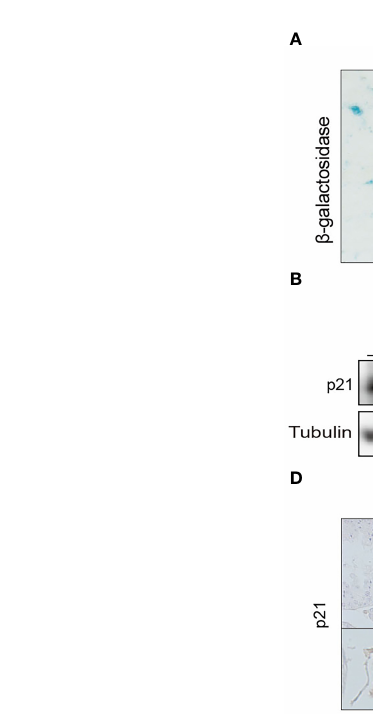
FIGURE 6 Assessment aging status of Leydig cell in p38LCKO mice and WT mice at 18-month of age. (A) SA- b -Gal staining in testes of two groups of mice was assessed by using staining kit. (B) The protein levels of p21 and p16 were detected by immunoblot. (C) Quantitative analysis for protein levels of p21 and p16. (D) IHC staining of p21 in testis tissue.